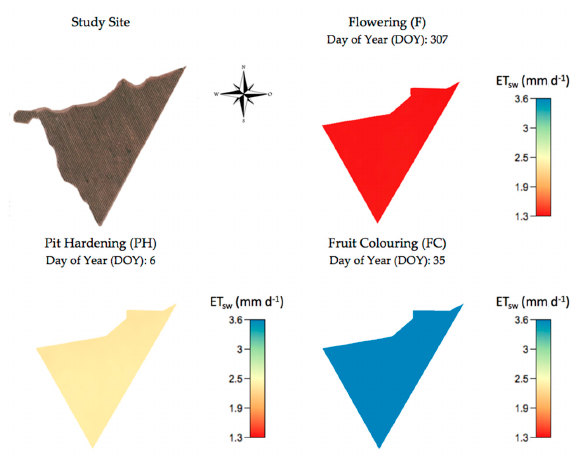
Figure 5. Maps of daily actual evapotranspiration (ET) computed from the SW model using remote sensing and meteorological data.